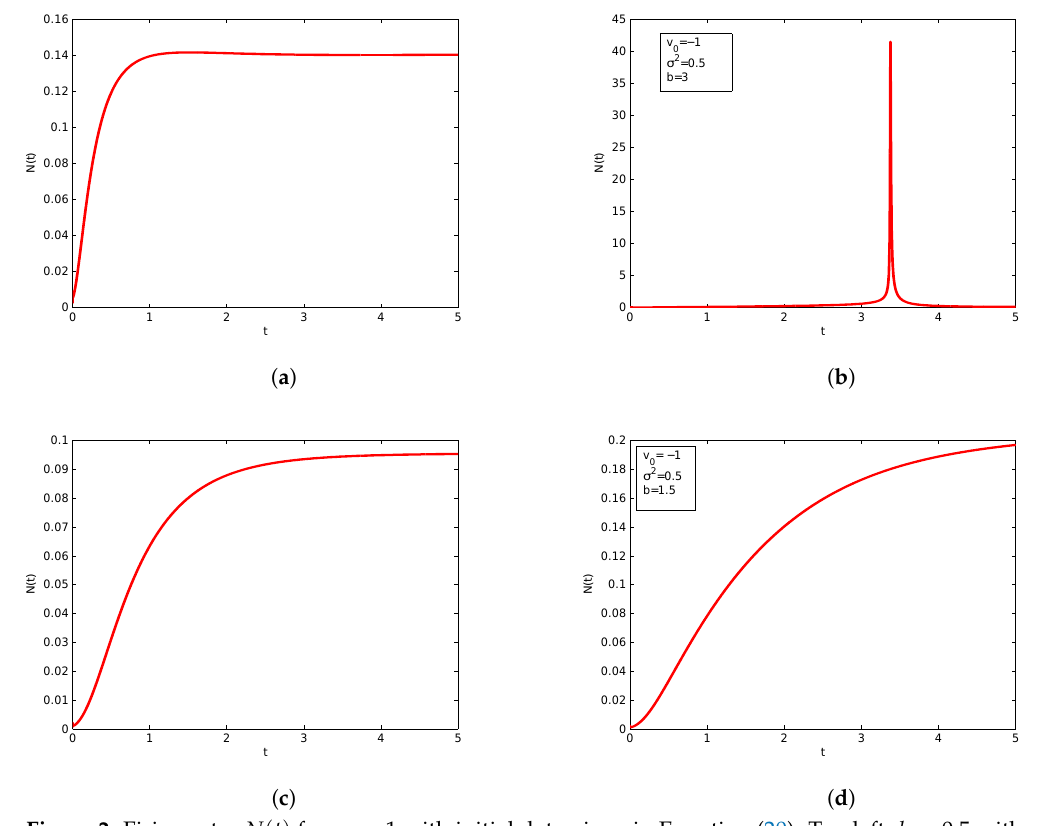
Figure 2. Firing rates N ( t ) for a 0 = 1 with initial data given in Equation (20). Top left: b = 0.5 with: v 0 = 0 and σ 2 = 0.25. Top-right: b = 3 with: v 0 = − 1 and σ 2 = 0.5. The top-right case seems to illustrate a blow-up phenomenon. Bottom left: b = − 1.5 with: v 0 = − 1 and σ 2 = 0.25. Bottom right: b = 1.5 with: v 0 = − 1 and σ 2 = 0.25.